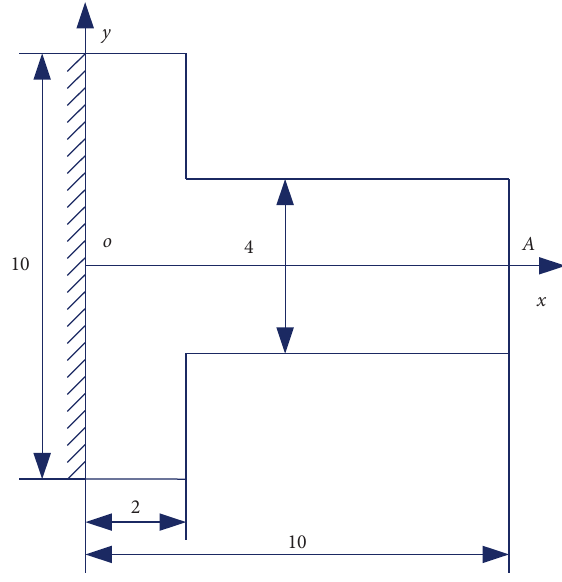
Figure 6: Geometry illustration of a T-plate.